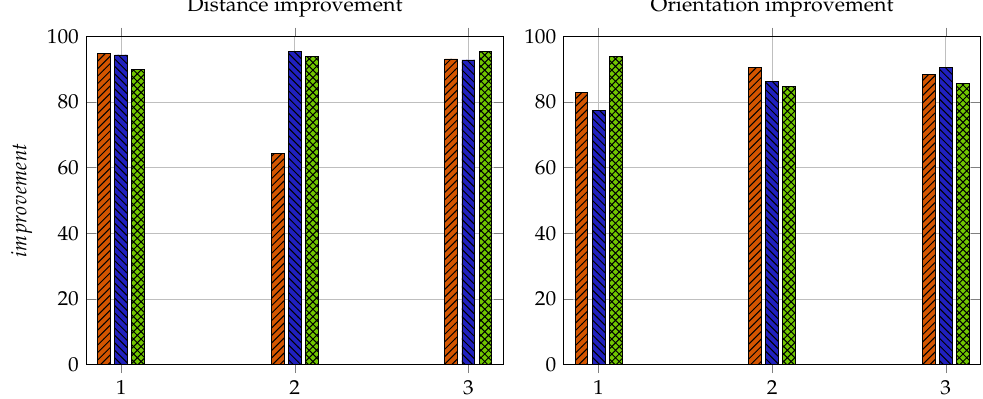
Figure 9. Distance and Orientation improvement in different